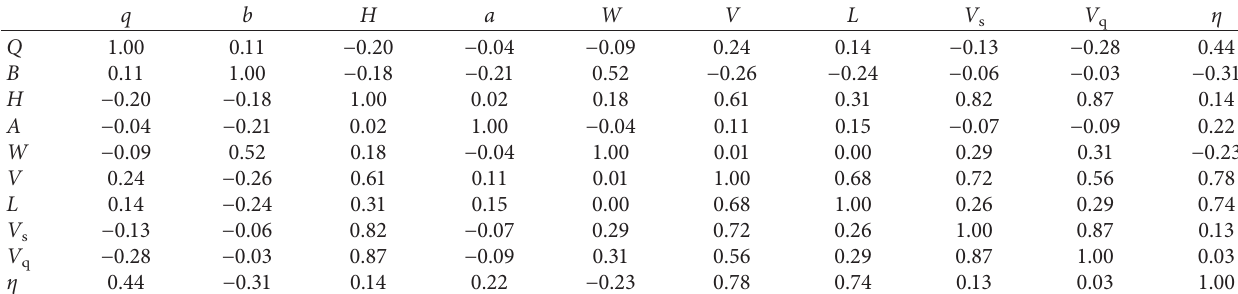
Table 2: Correlation matrix of original